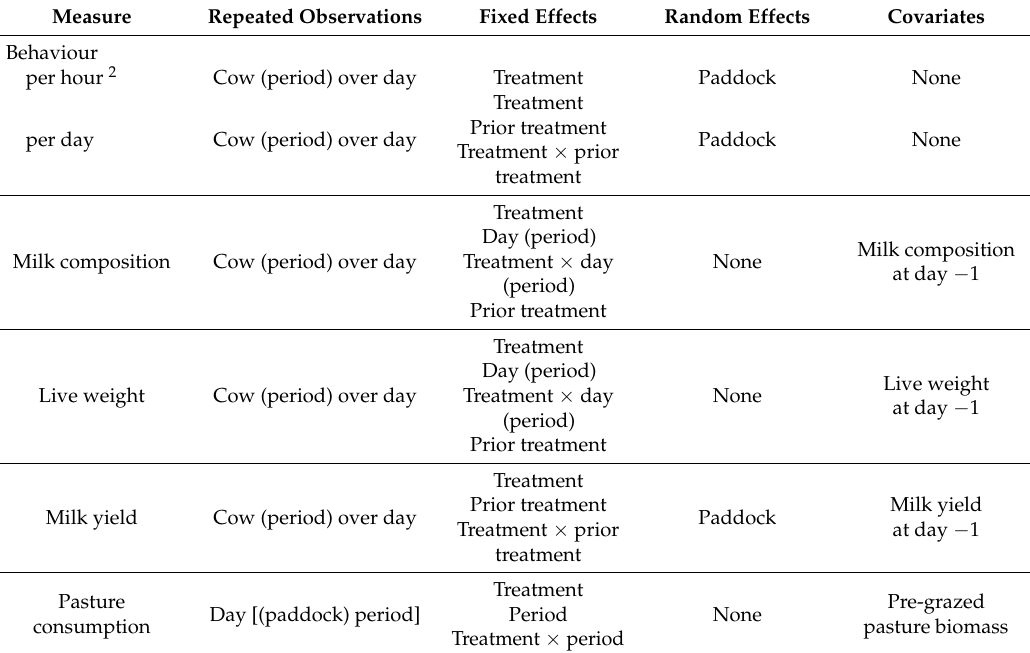
Table 1. Summary of linear mixed models used to assess effects of feeding frequency on measures of dairy cow behaviour, milk production, live weight, and estimated pasture consumption 1